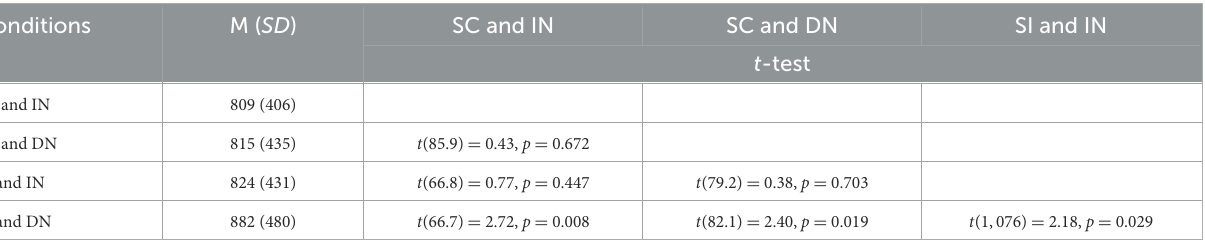
TABLE 3 Contrast analyses for the first spillover segment of Experiment